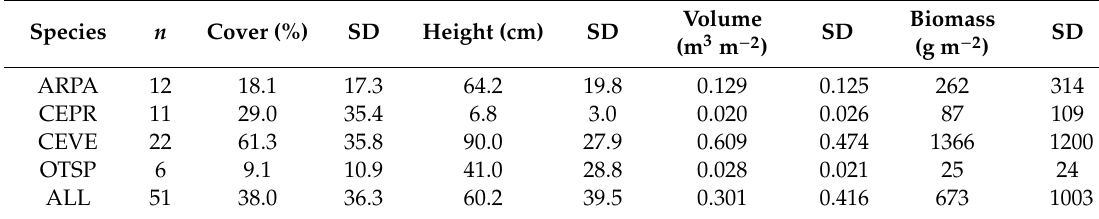
Table 1. Summary statistics for cover (percent), height (cm), volume (m 3 m –2 ), and shrub biomass (g m –2 ) sampled by species (ARPA = Arctosaphylos patula , CEPR = Ceanothus prostratus , CEVE = Ceanothus velutinus , and OTSP = other species).